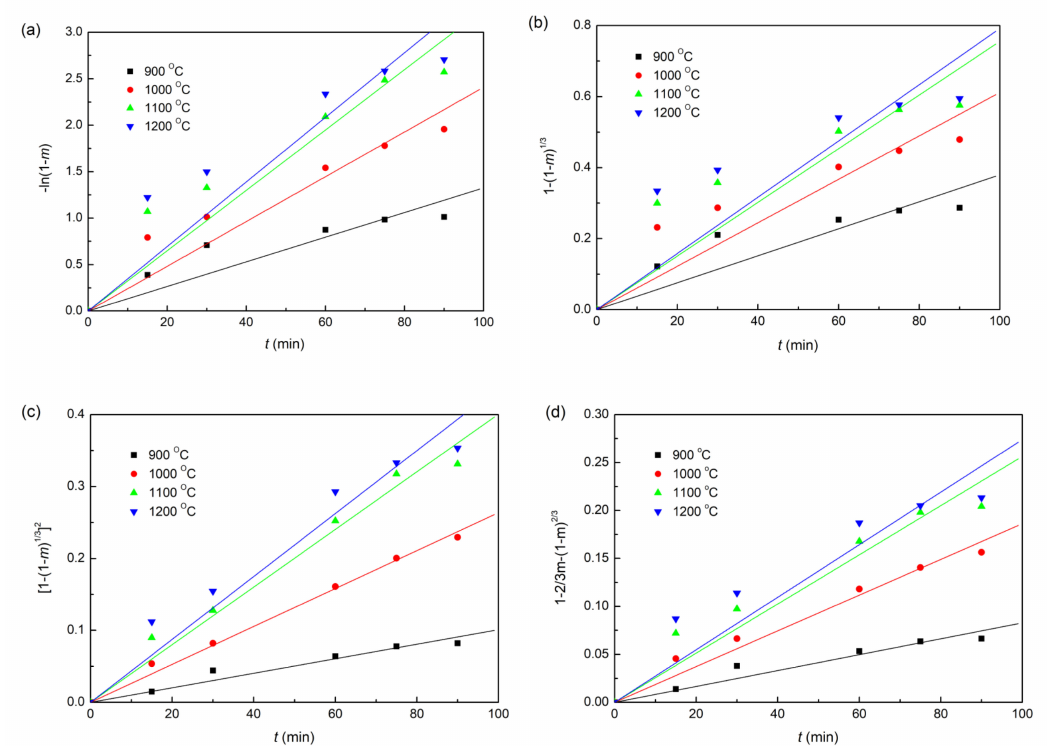
Figure 7. Linearized form plots of kinetic model for reduction of iron ore in iron ore–charcoal composite